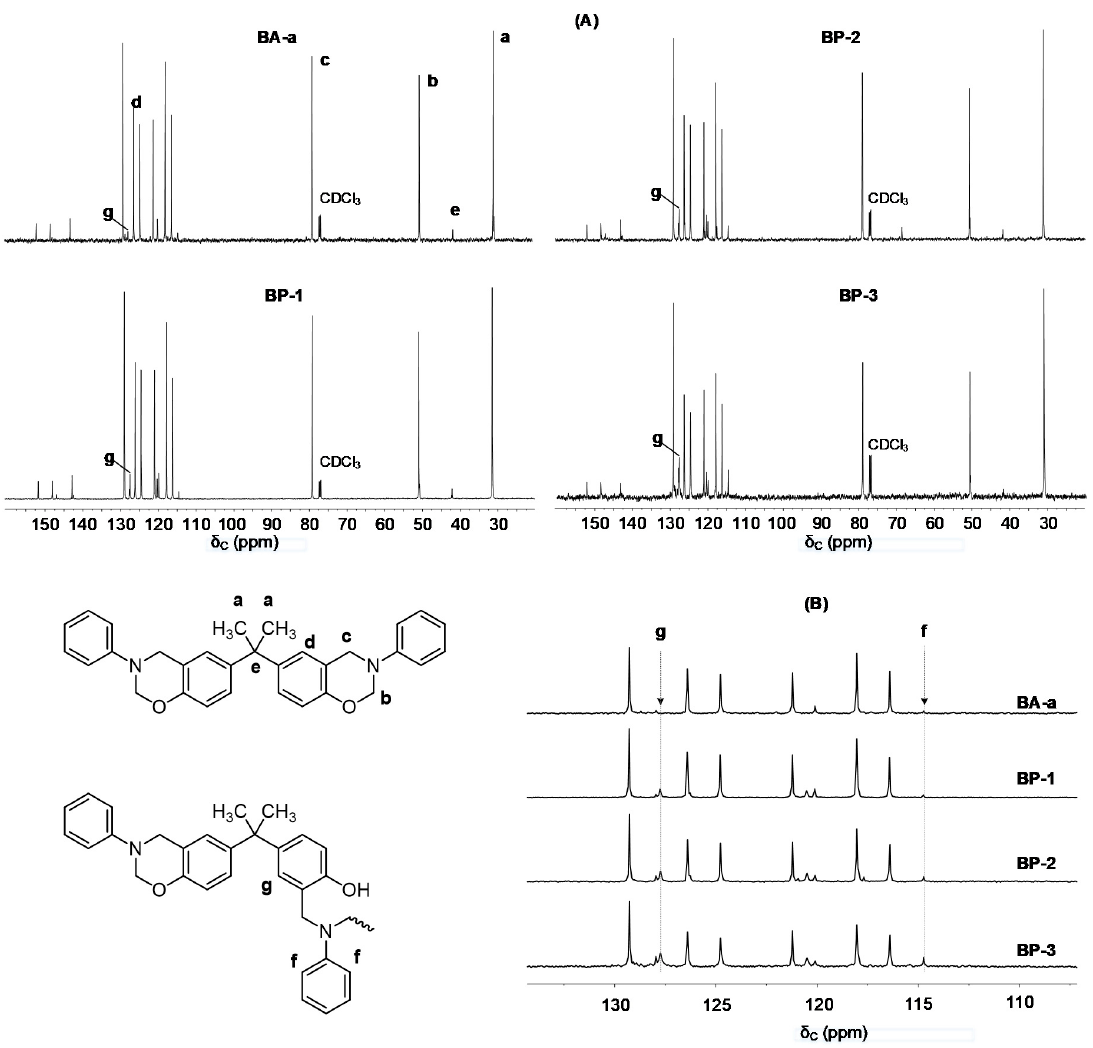
Figure 7. 13 C NMR spectra of benzoxazine oligomers ( A ) and their enlarged fragments ( B Figure 7. 13 С NMR spectra of benzoxazine oligomers ( A ) and their enlarged fragments ( B ).